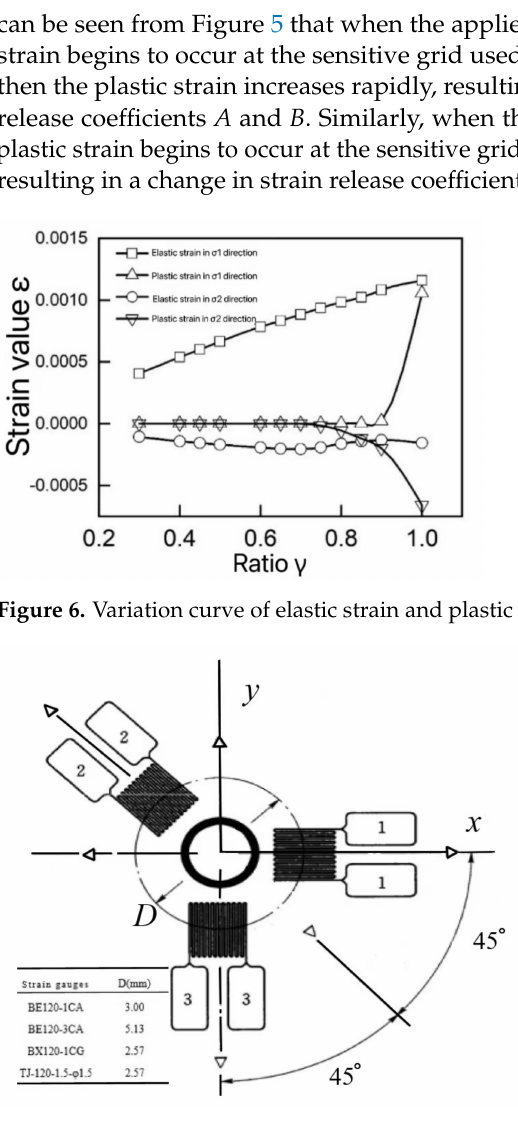
Figure 7. Schematic diagram of rosette